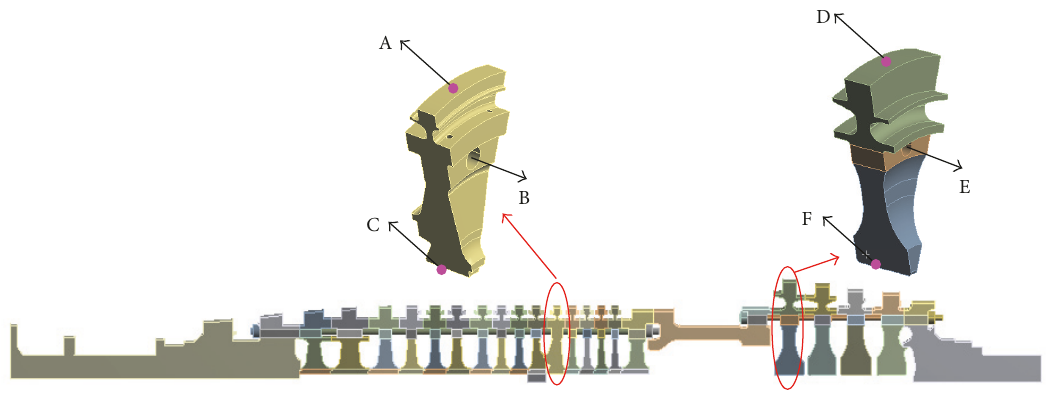
Figure 6: Monitoring locations on the gas turbine rotor.